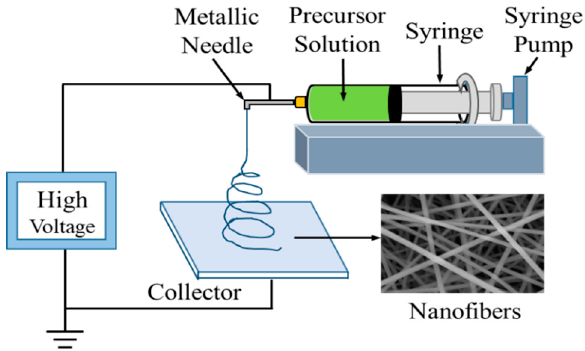
Figure 1. Schematic diagram of electrospinning.